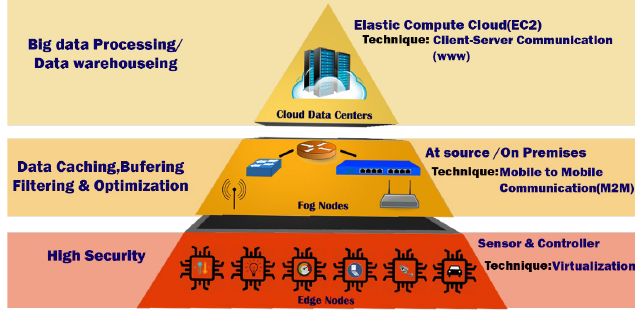
Figure 1. Architecture of Edge computing